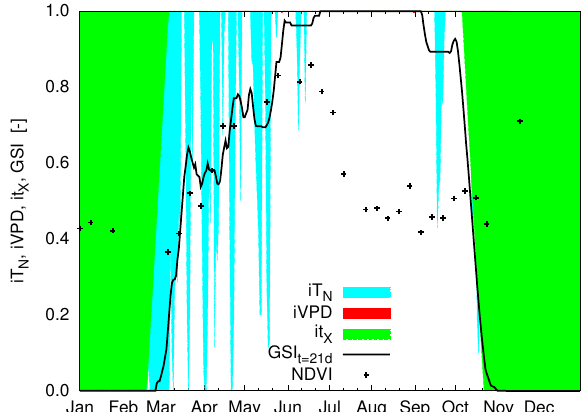
Fig. 2. Time series of the GSI for observations from G¨ottingen cli- mate station (agriculture, latitude 51.50 ◦ N, longitude 9.95 ◦ E) for the entire year 2005. Filled areas indicate constraints due to low minimum temperatures, high water vapor deficit values or short day lengths. Fig. 3. Beginning of spring as observed (blue) and calculated (red) for three different sites in Lower Saxony.